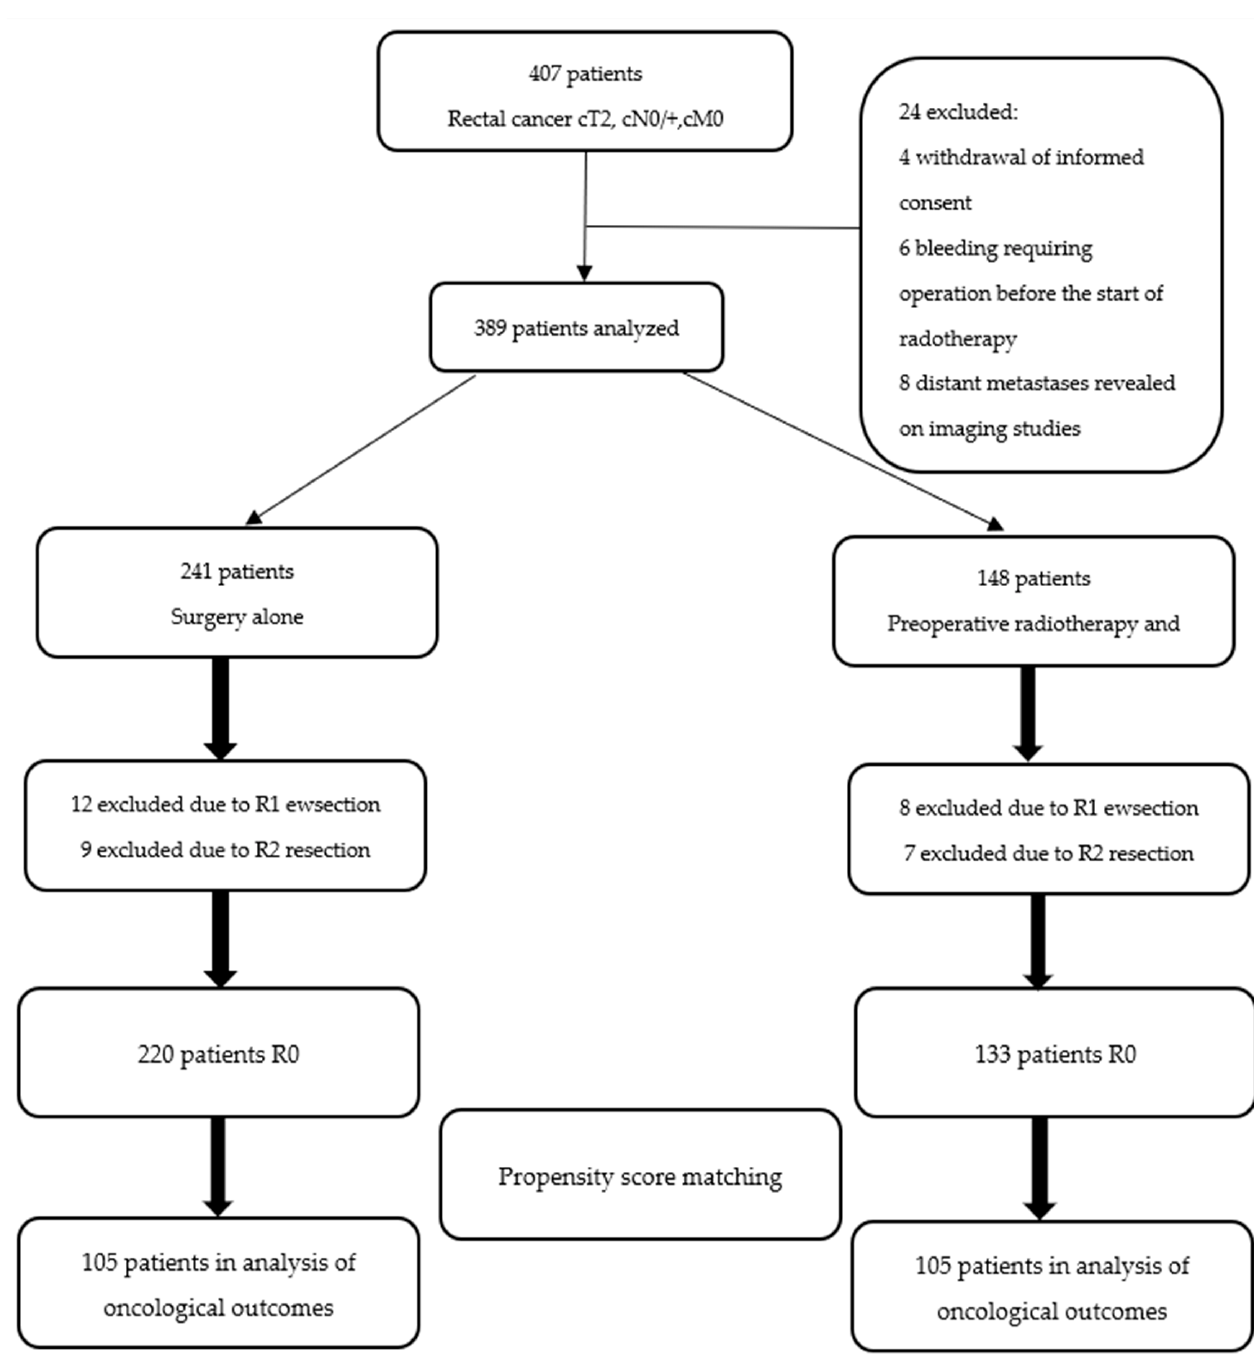
Figure 1. Flow-diagram of the study.